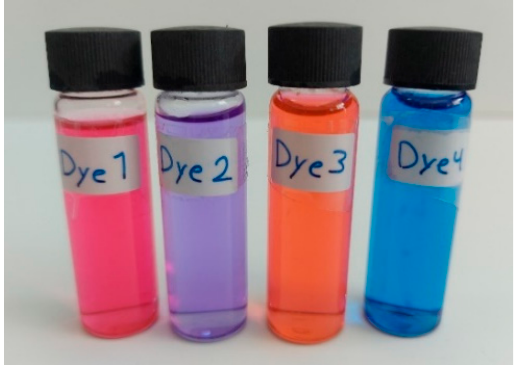
Figure 7. Aqueous solutions of the investigated dyes at (10 mg/100 mL), pH 7: Dye 1 (pink), Dye 2 (violet), Dye 3 (orange), and Dye 4 (deep blue).